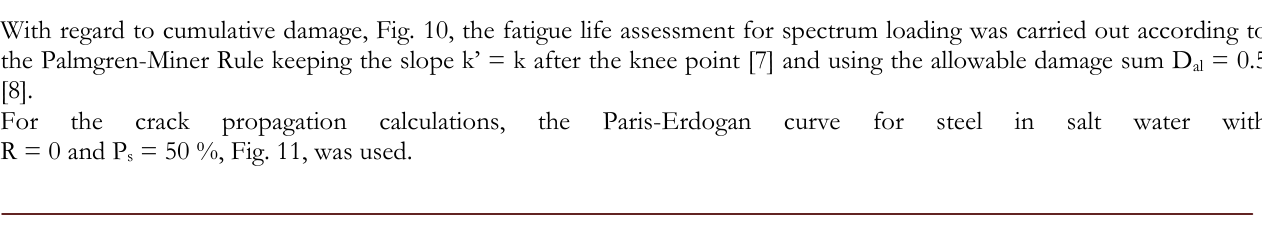
Table 1: FAT-values according to the notch stress concept for different reference radii and strength hypotheses (PSH: Principal stress